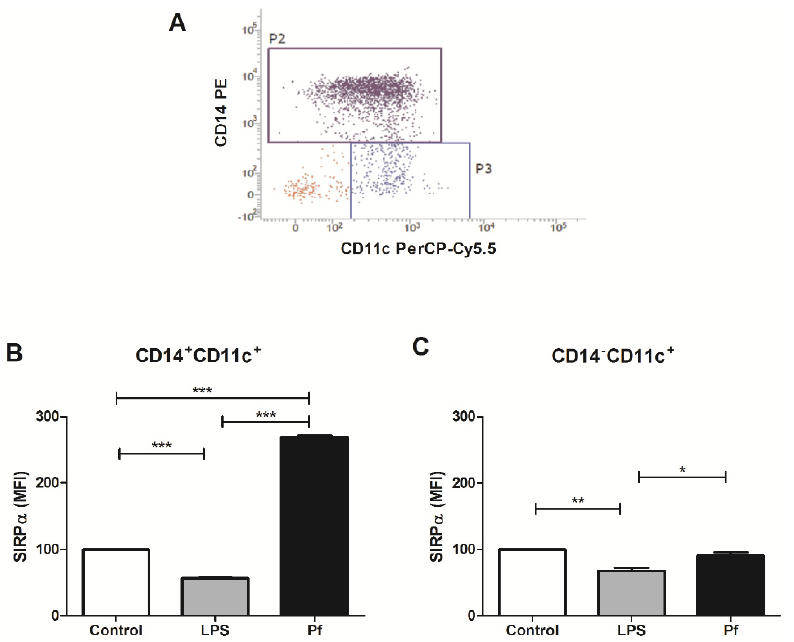
Figure 4. Cell type-specific modulation of SIRP α expression by P. falciparum crude extract. PBMCs from healthy individuals were stimulated for 24 h with P. falciparum extract (10 µ g/mL) or LPS (5 µ g/mL) and SIRP α expression on cell surface of monocytes and dencritic cells was evaluated by flow cytometry. ( A ) Representative phenotyping analysis of classical monocytes (P2; CD14 + CD11 + ) and myeloid dendritic cells (P3; CD14 − CD11 + ) populations. ( B , C ) Levels of SIRP α expression in gated monocytes ( B ) and dendritic cells ( C ), as measured by mean fluorescence intensity (MFI). Non-stimulated PBMCs were used as control (Control). Data are shown as mean ± standard error (SEM) and represent one of two independent experiments performed with PBMC samples from five individuals. *: p < 0.05; **: p < 0.01; ***: p < 0.001.